Question: Provide a one-line summary of what is displayed.
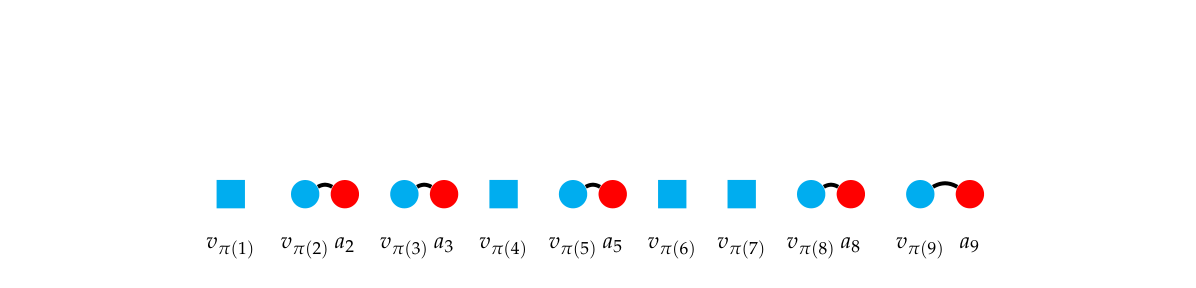
Answer: The graph G′ after the first step of the construction. Throughout our illustration figures, vertices of A1 (respectively, B) are colored red (resp., blue). Vertices of A1, B1 (resp., A2, B2) are circular (resp., rectangular).